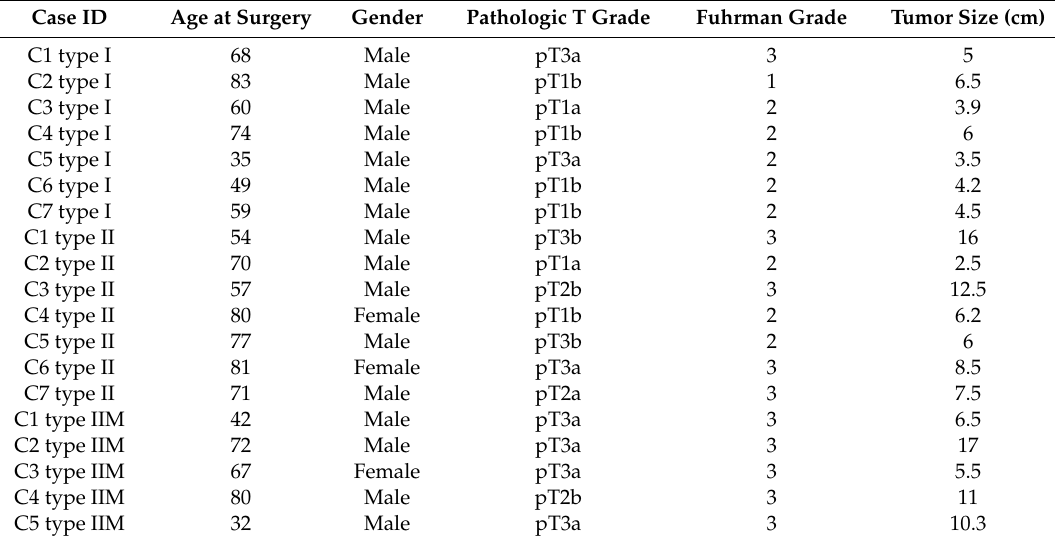
Table 1. Clinical and pathologic features of the pRCC cohort.